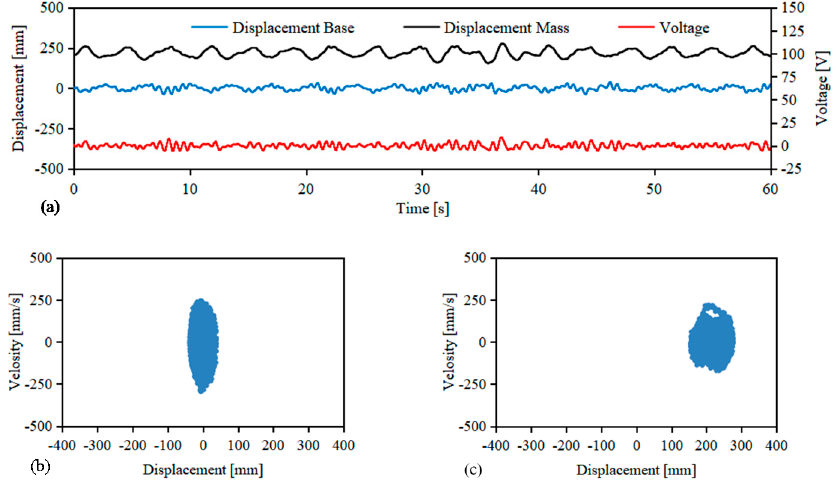
Figure 12. Measurement results of response vibration displacement and vibration power generation when vibrating with a random signal and a period signal 0.3 Hz. ( a ) Results of response vibration displacement. ( b ) Diagram of displacement velocity of vibration of the support. ( c ) Diagram of displacement velocity of vibration of the mass block.